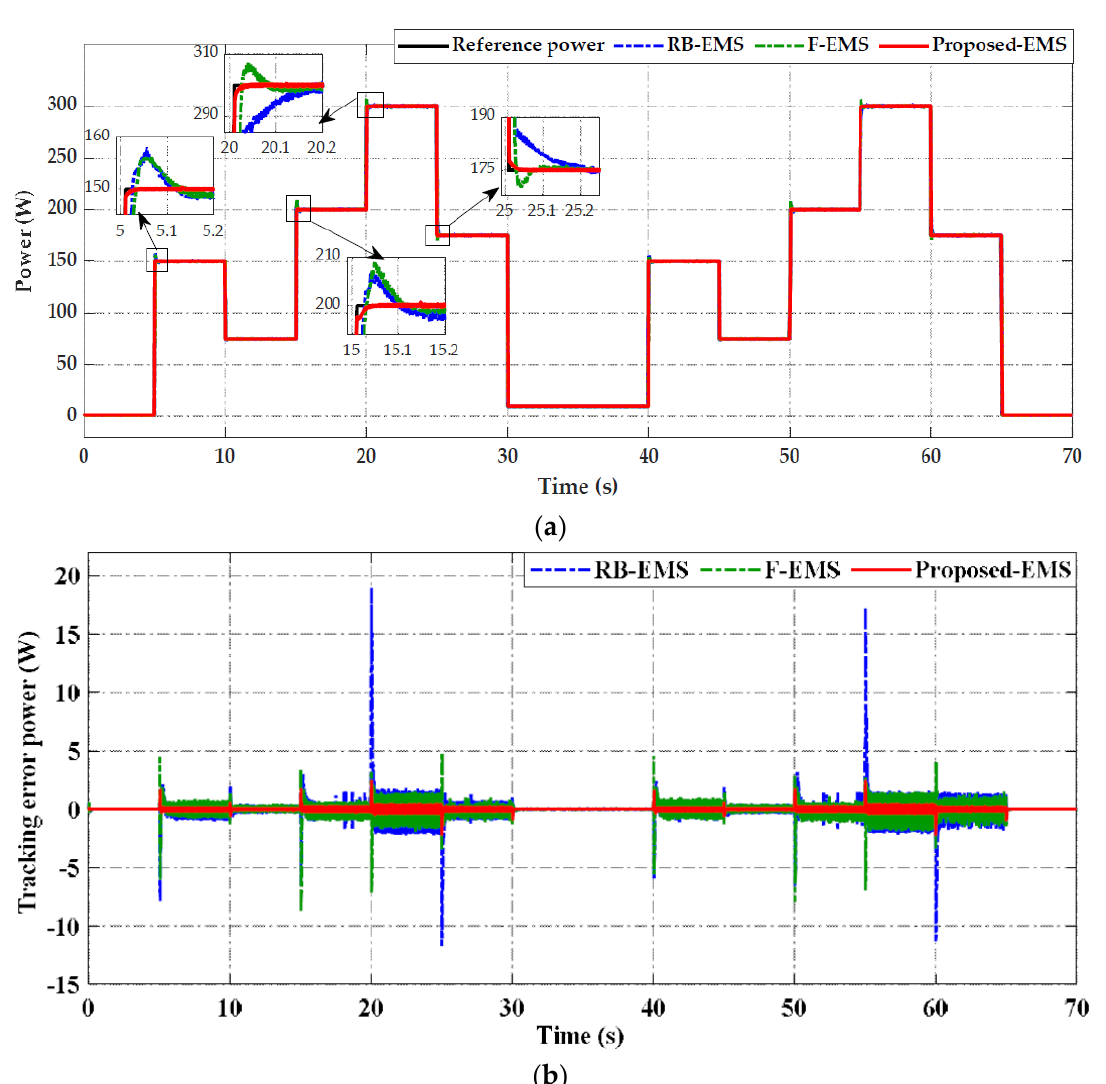
Figure 18. The comparison power of three EMSs. ( a ) The adaptation of load power. ( b ) The tracking error power.